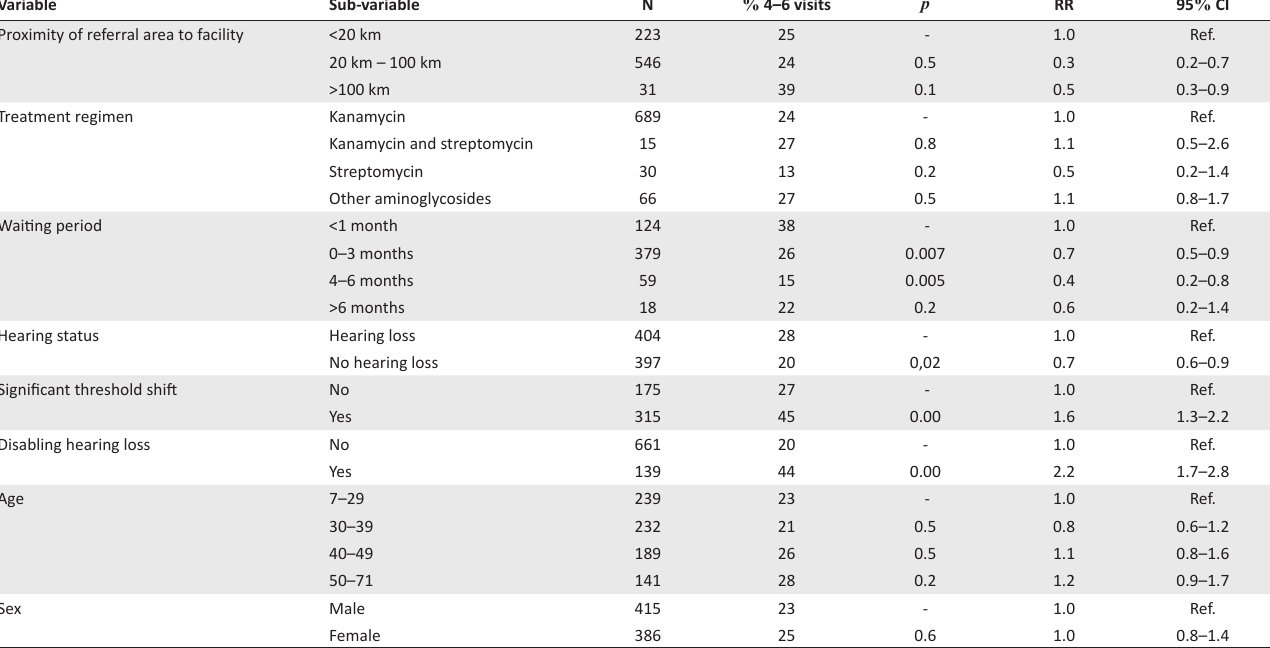
TABLE 2: Variables associated with regular attendance of scheduled ototoxicity monitoring appointments (i.e. 4–6 visits).